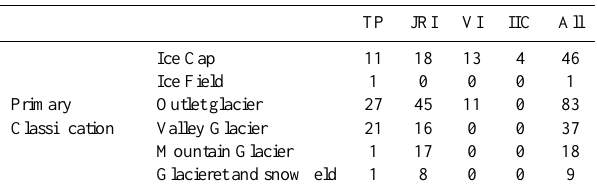
Table 6. Summary of glacier descriptors. All=all glaciers.